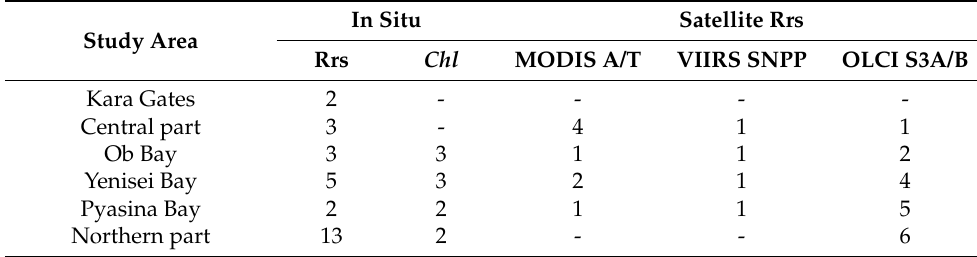
Table 1. Study areas and corresponding numbers of in situ and remote sensing